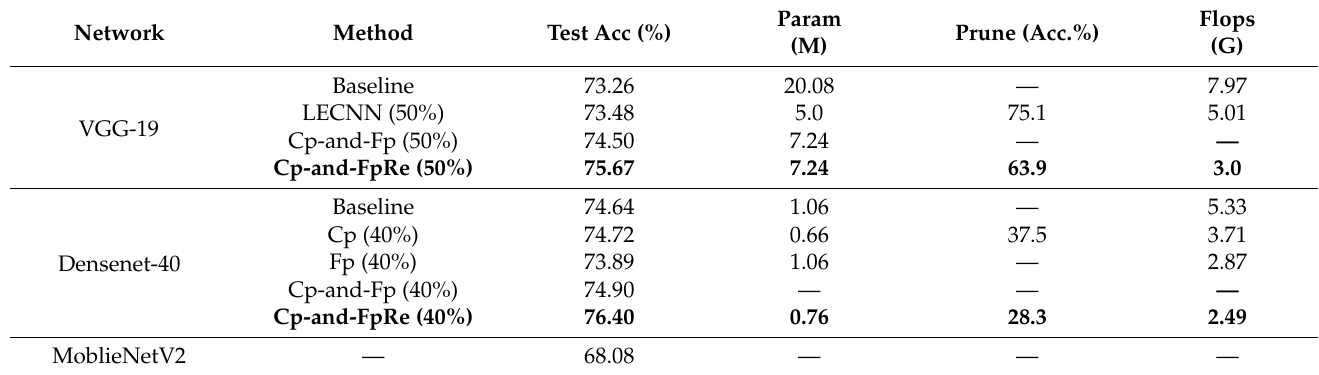
Table 2. Comparison of pruning effects of models VGG19 and DenseNet40 on CIFAR100 dataset.